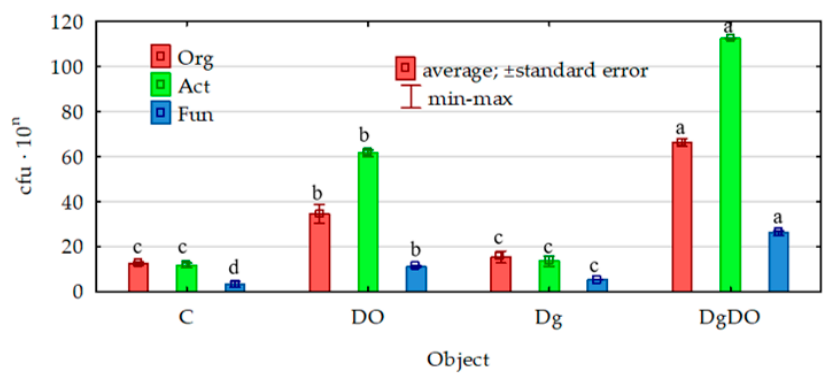
Figure 1. Effect of diesel oil (DO) and Dactylis glomerata (Dg) on the numbers of organotrophic bacteria and actinobacteria, 10 9 cfu kg − 1 d.m. soil, and fungi, 10 7 cfu kg − 1 d.m. soil. Homogeneous groups denoted with letters (a–d) were calculated separately for each of the microorganisms. C—non-polluted and non-sown soil, Dg—non-polluted soil sown with Dactylis glomerata , DO—non-sown soil polluted with diesel oil, DgDO—soil polluted with diesel oil and sown with Dactylis glomerata .